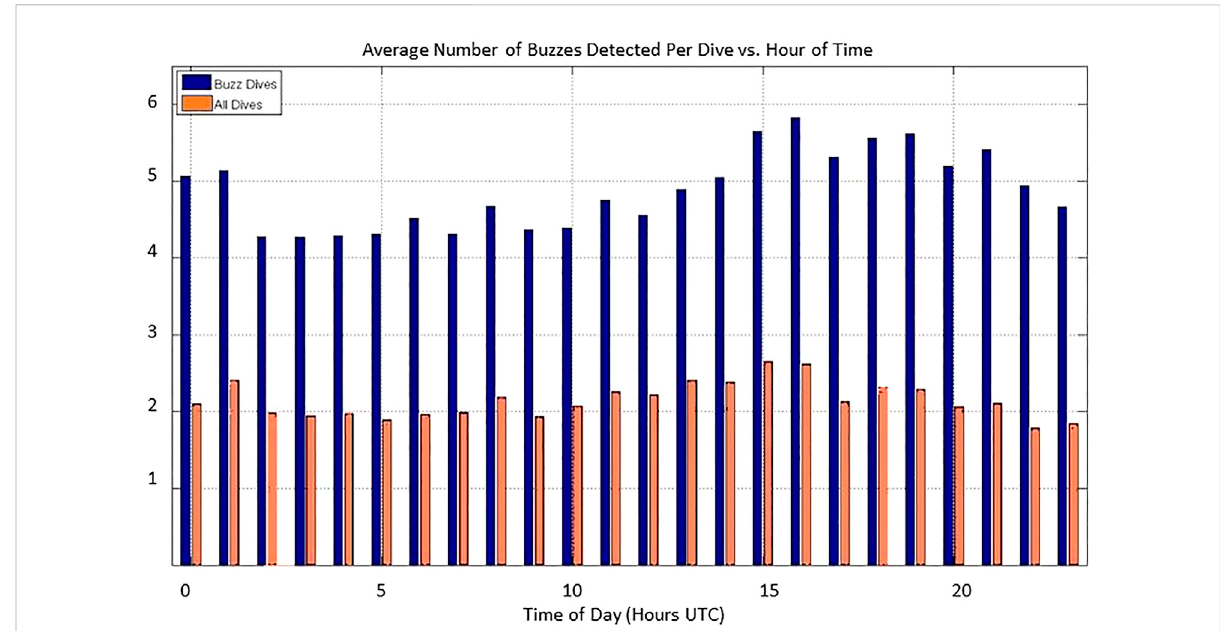
FIGURE 7 Average number ofbuzzes detected per group foraging diveversustime of day(Z). Local night of6p.m. to 6a.m. correspondsto 0200-1400Z. Averages formed over entire study period from July 2014 to December 2017. Orange bars are the average over all group dives and blue bars represent the average over dives during which buzzes were